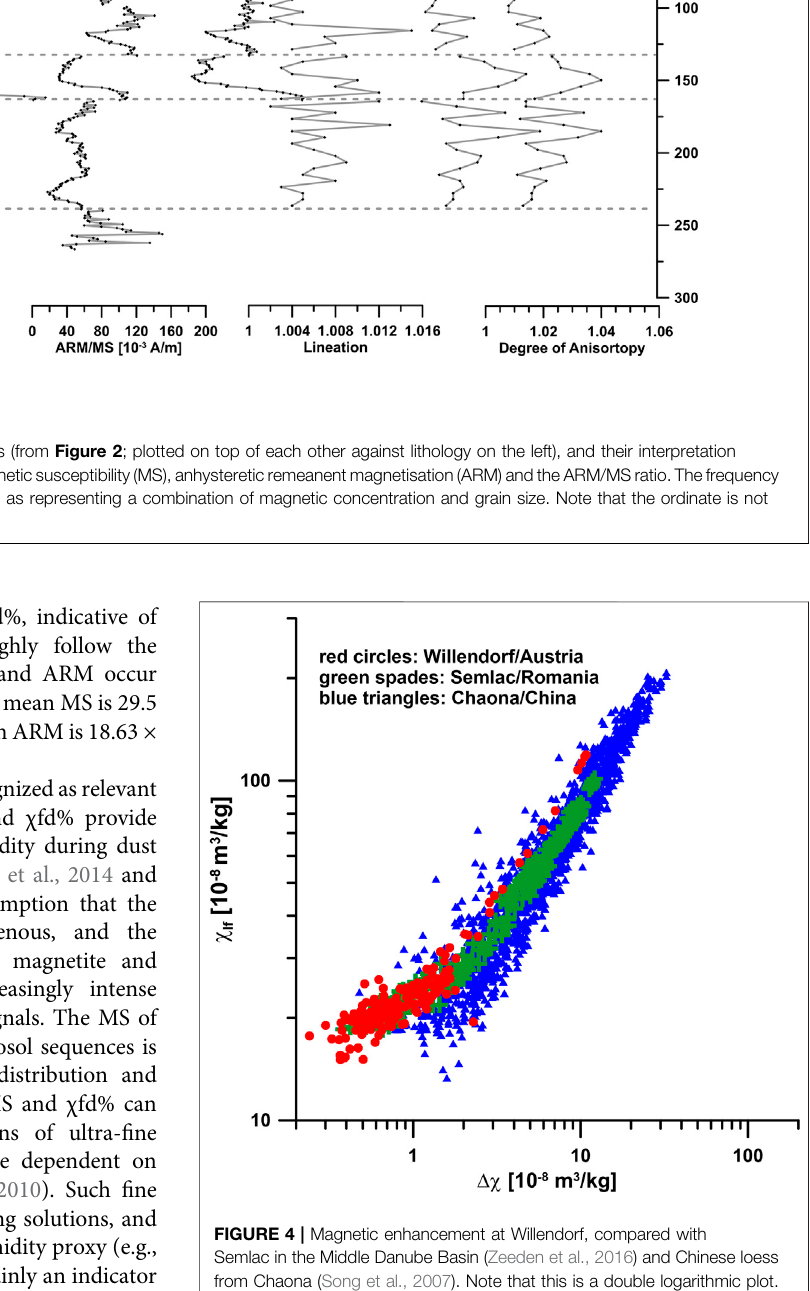
Frontiers in Earth Science |